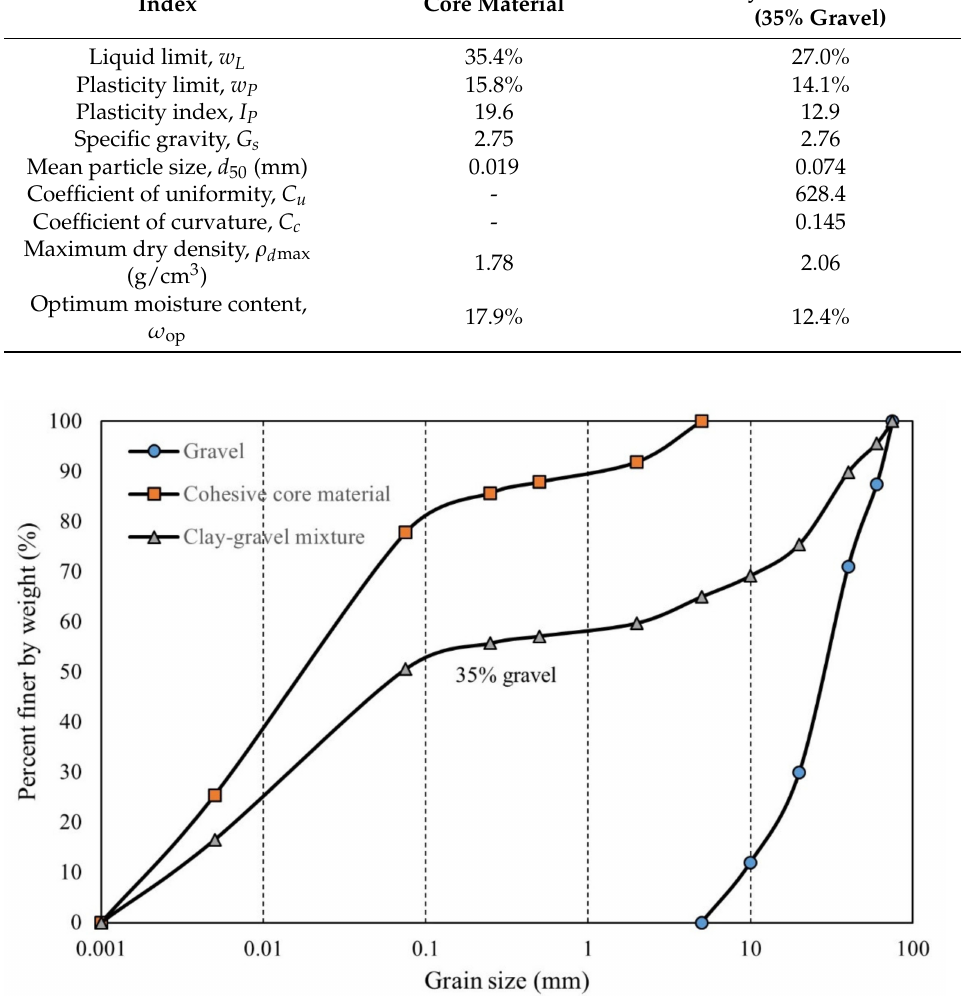
Figure 7. GSD curve of original-graded test